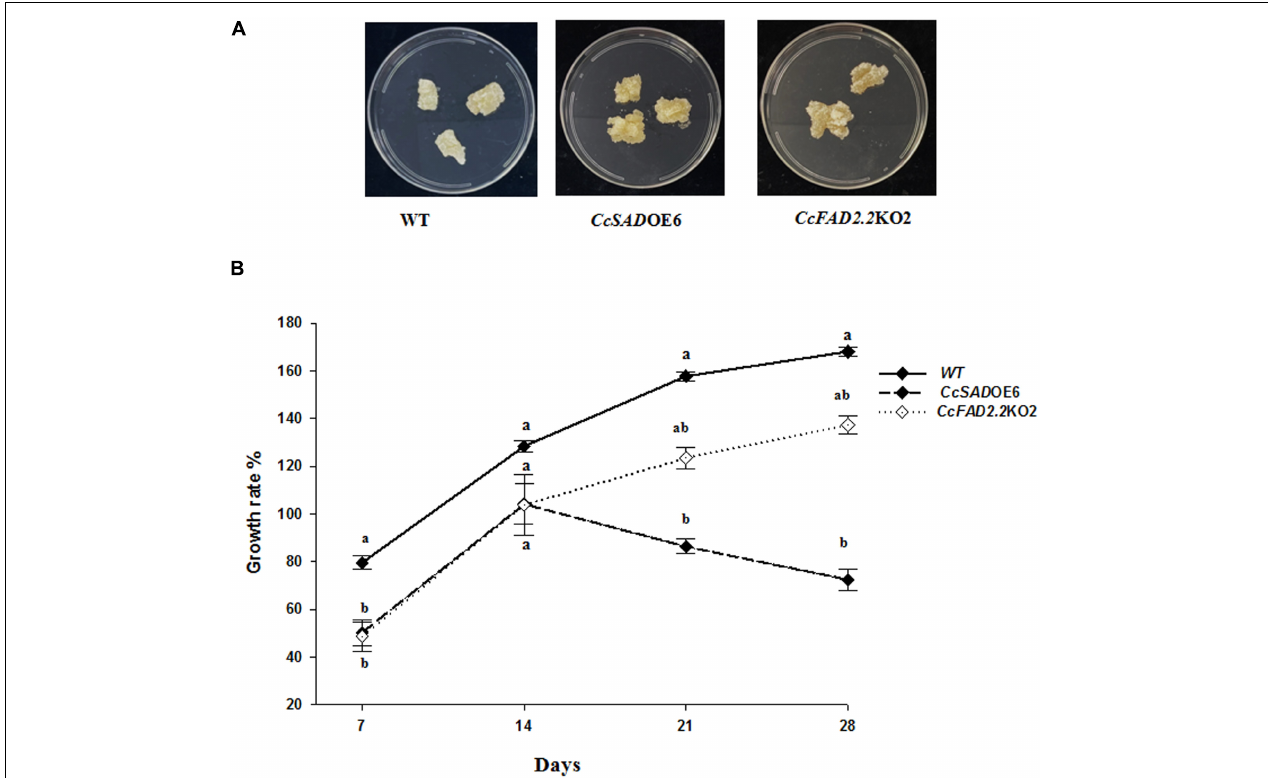
FIGURE 5 | Phenotype and growth of cardoon lines. (A) Phenotype of C. cardunculus wild type (WT), SAD6 overexpressing line ( CcSADO E6), and FAD2 silenced line ( CcFAD2.2 KO2). (B) Growth rate measurements of WT, Cc SADOE6, and Cc FAD2.2KO2 transformed cardoon lines at 7-, 14-, 21-, and 28-day culture on fresh media. The data are presented as mean ± SD/10 ( n = 16). Different letters indicate statistical differences ( p <